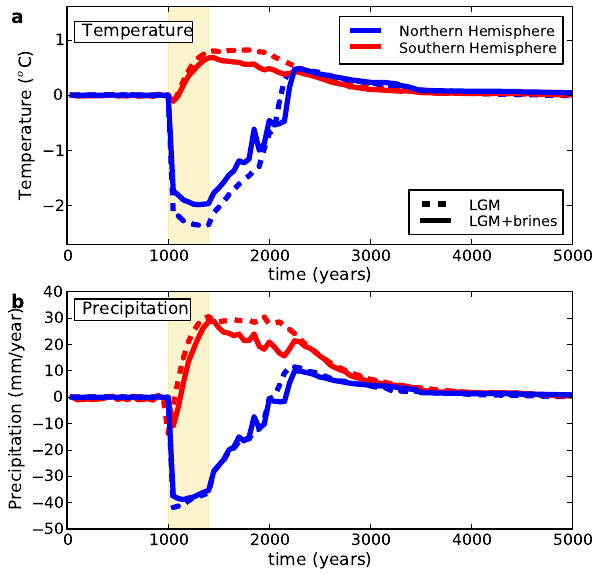
Fig. 13. Evolution of (a) air temperature ( ◦ C) and (b) precipitation (mmyr − 1 ) in the Northern (blue) and Southern (red) Hemispheres for the simulation with a fresh water flux added into the North At- lantic of 0.5Sv during 400 yr. Two background climate states are considered: the Last Glacial Maximum (LGM, dashed lines) and the Last Glacial Maximum with the sinking of brines (LGM+brines, solid lines).